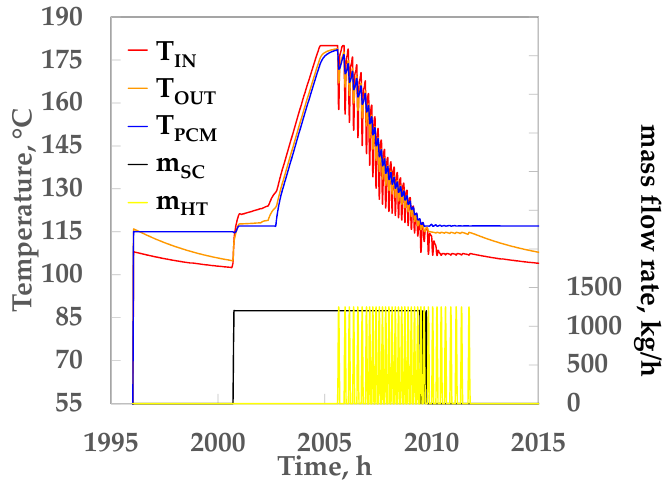
Figure 12. Temperature profiles and flow rates of LHST for water at 0.25 m 3 and 20 m 2 .